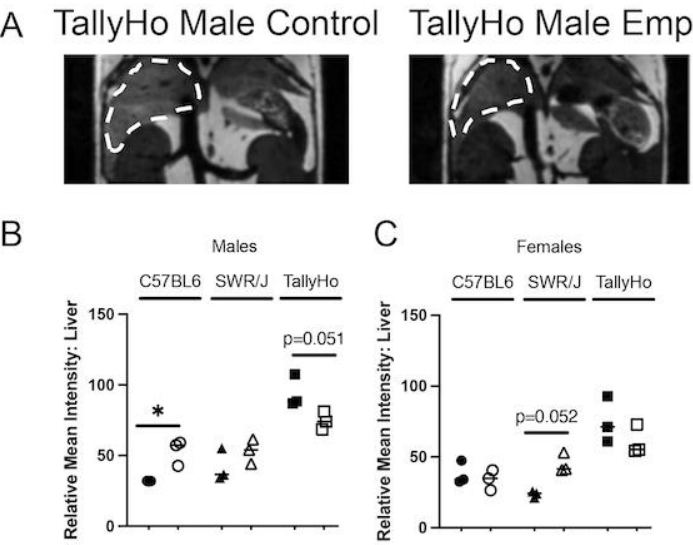
Figure 4. Empagliflozin decreases liver steatosis. MRI was performed on both male and female TallyHo, SWR/J, and C57BL6J mice following 12 weeks of Empagliflozin treatment. ( A ) Regions of lighter intensity seen in the livers is an indication of lipid accumulation (dashed outline). A represen- tative image is shown for both a TallyHo control and Empagliflozin-treated male mouse. ( B , C ) The relative mean intensity of the liver region was measured for each animal (( B )—male; ( C )—female). * p < 0.05 between control and Empagliflozin.